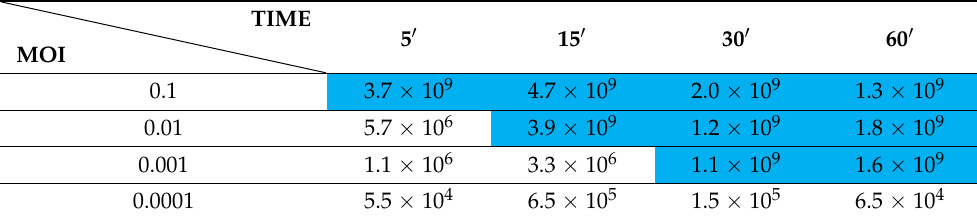
Table 1. The RNA viral load (expressed as average viral copies for ml of 3 experimental replicates) at 7 days post infection and at the different MOI (multiplicity of infection 0.1, 0.01, 0.001, and 0.0001) and timing tested (5, 15, 30, and 60 min). In light blue are displayed the experimental settings where an established infection was